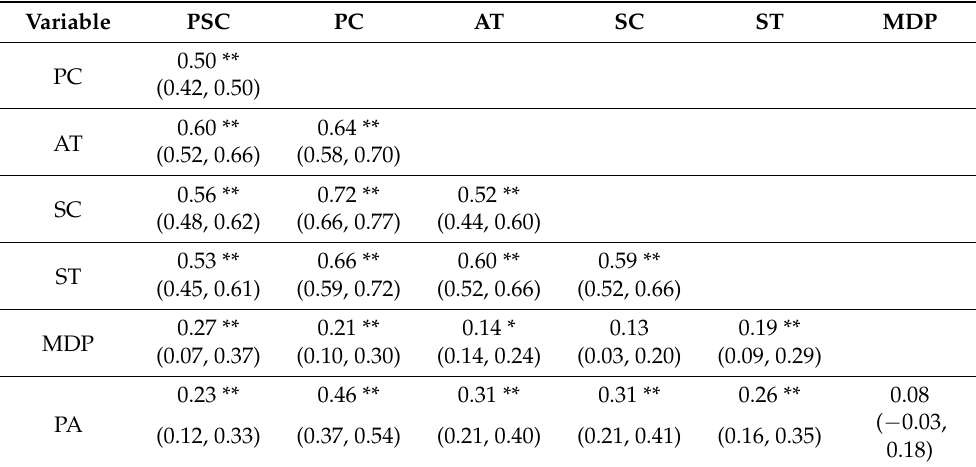
Table 2. Bivariate correlations between the physical self-concept ´ s dimension, adherence to Mediter- ranean diet pattern, and physical